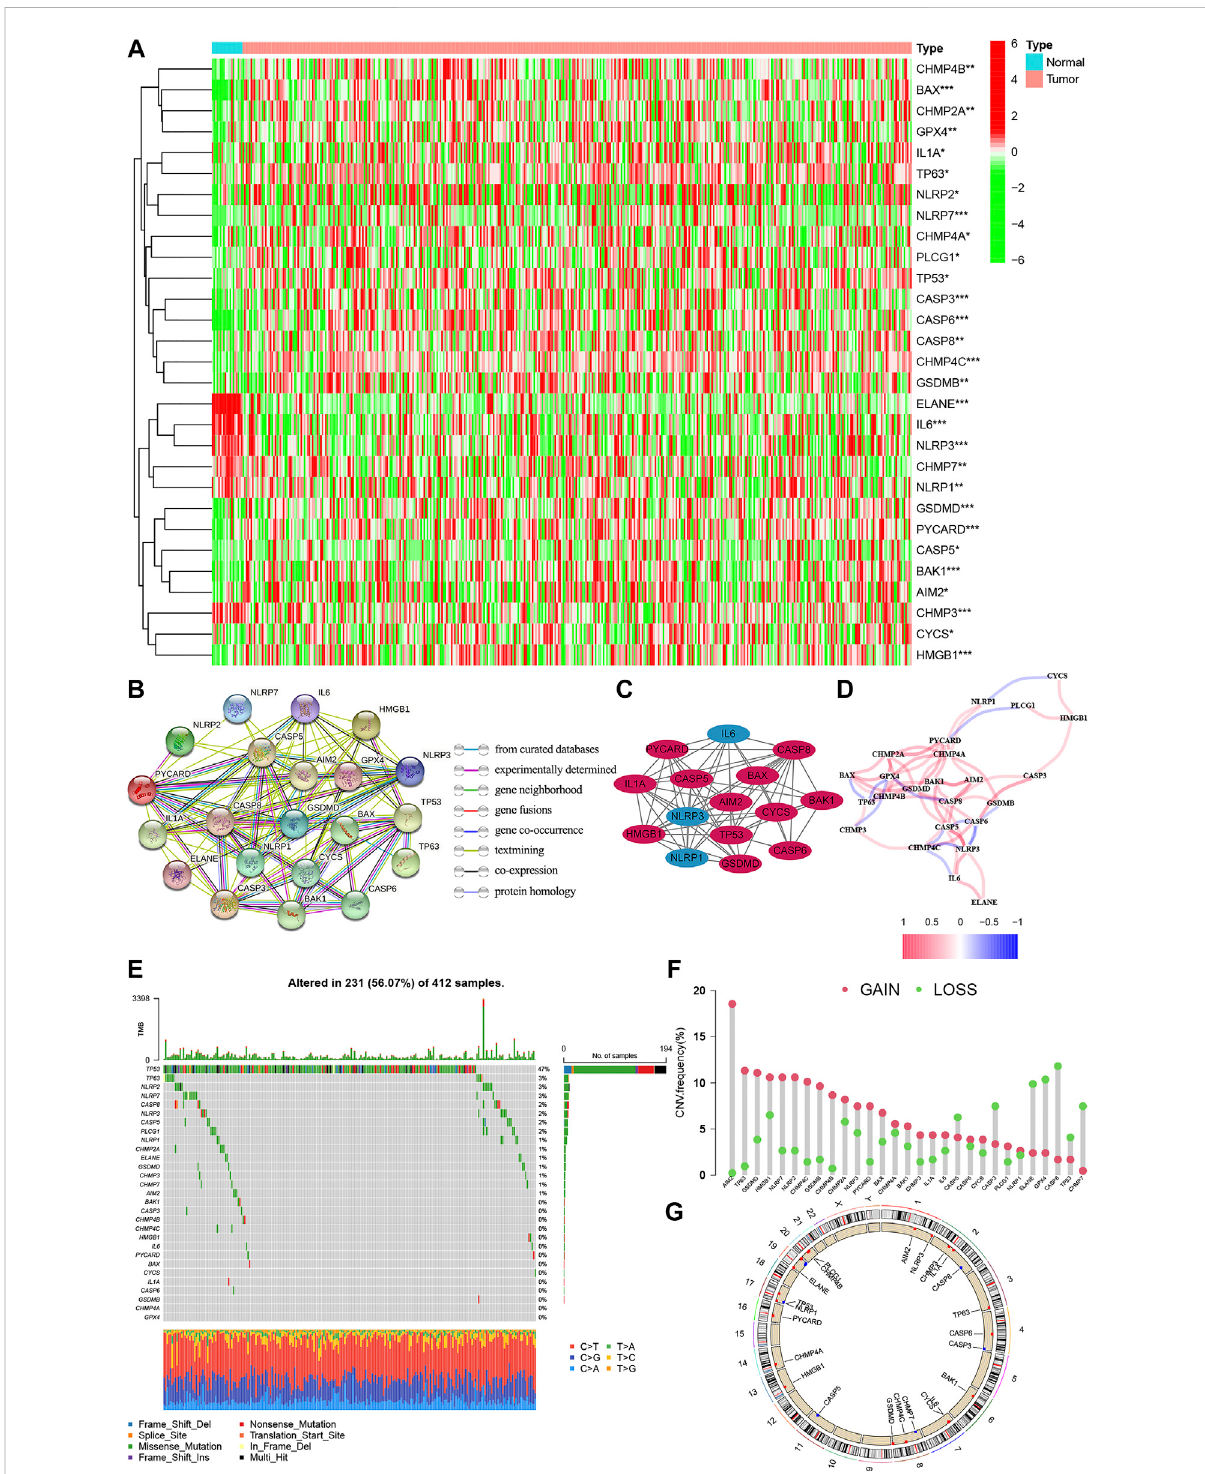
FIGURE 2 The expression of pyroptosis-related genes in BC. (A) Heatmap of the 29 pyroptosis-correlated genes in BC and normal tissues. 23 genes were up-regulated, while 6 were down-regulated in the BC group. (B) PPI network of the interaction with the interaction score sett as 0.9. (C) The hub geneswereobtainedfromthePPInetworkwith15genesusingtheMCODEplug-in. (D) Therelationshipnetworkofthepyroptosis-correlatedgenes. Red and Blue lines: positive and negative correlation. (E,F) : Genetic alterations and CNV variation frequency of pyroptosis-correlated genes in BC, and TP53 had the highest mutation frequency. (G) Location of CNV alterations in BC. CNV, copy number variation; PPI, protein-protein interaction